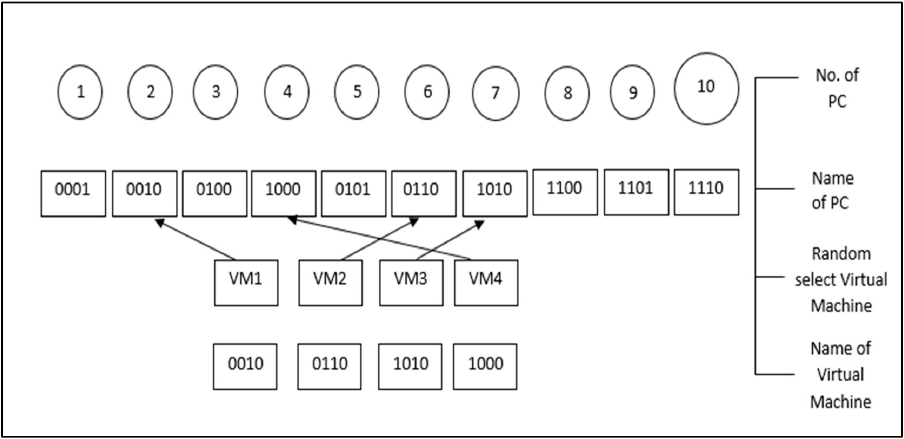
Figure 3. Random selections of V.M machine using algorithm.